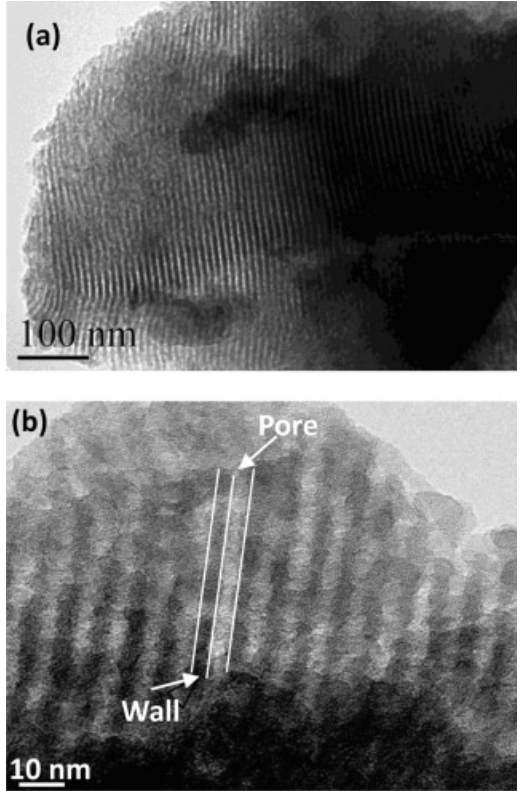
Figure 7. Transmission electron microscopy images of ( a ) P123-templated MBG and ( b )